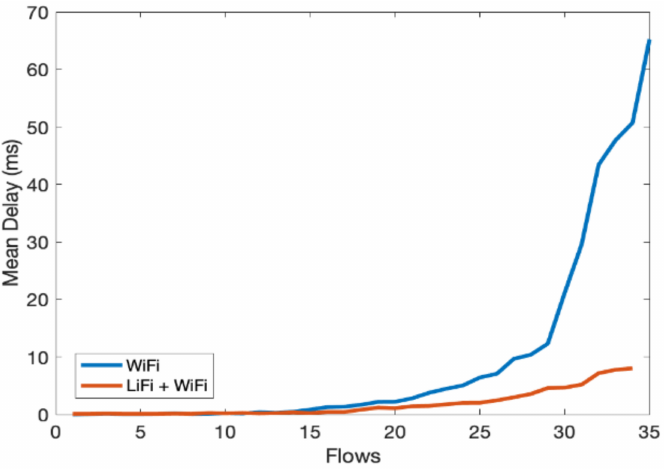
Figure 9. Average delay vs. number of